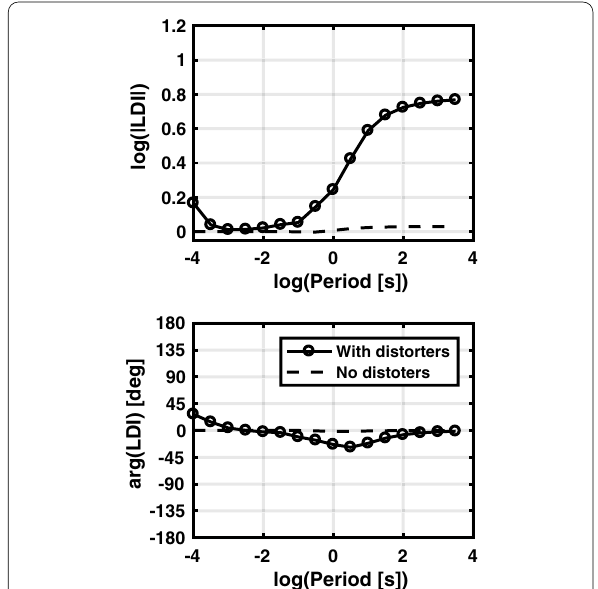
Fig. 23 Examples of LDI from a strongly distorted station (syn‑0505) for which the PT in arctangent scaling is shown in Fig. 22. The LDI at this station obtained from the synthetic undistorted model is shown by dashed curves for comparison